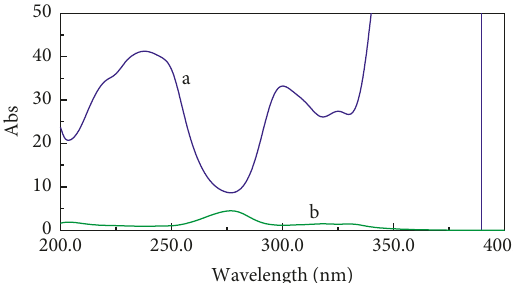
Figure 4: 5.0 μ g/ml of (CIP) spectra representing. (a) Absorptivity inverse (1/a) of (CIP), and (b) Factorized spectrum of (CIP) (FS ′